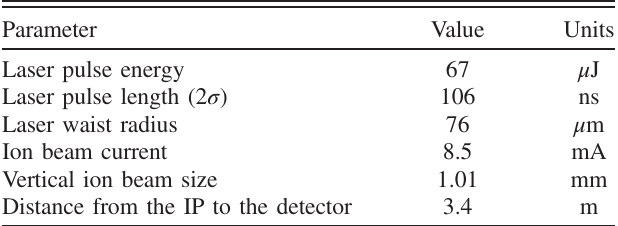
TABLE I. Photo-detachment signal simulation parameters.